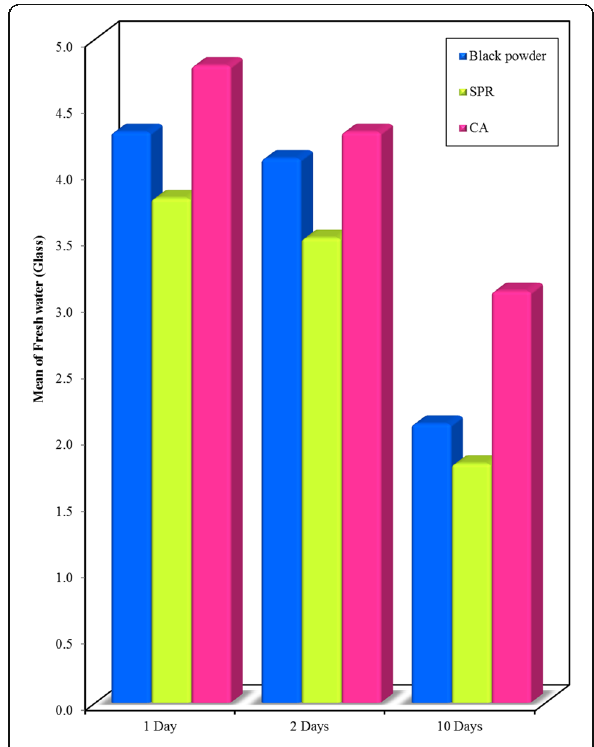
Fig. 9 Bar graph - Comparison between the Black powder, SPR and CA development techniques at different time intervals (1, 2, and 10 days) on glass surface recovered from freshwater . It shows that highest mean visibility score of prints developed using CA